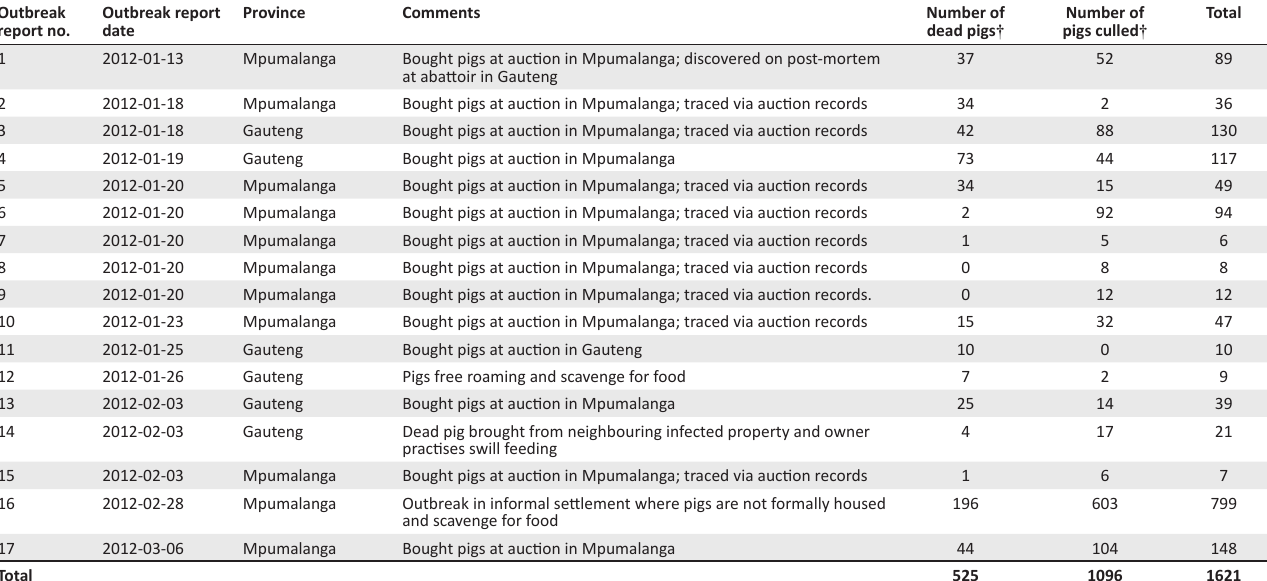
TABLE 1: Summary of the 2012 African swine fever epidemic outside the South African controlled area. Outbreak report no.